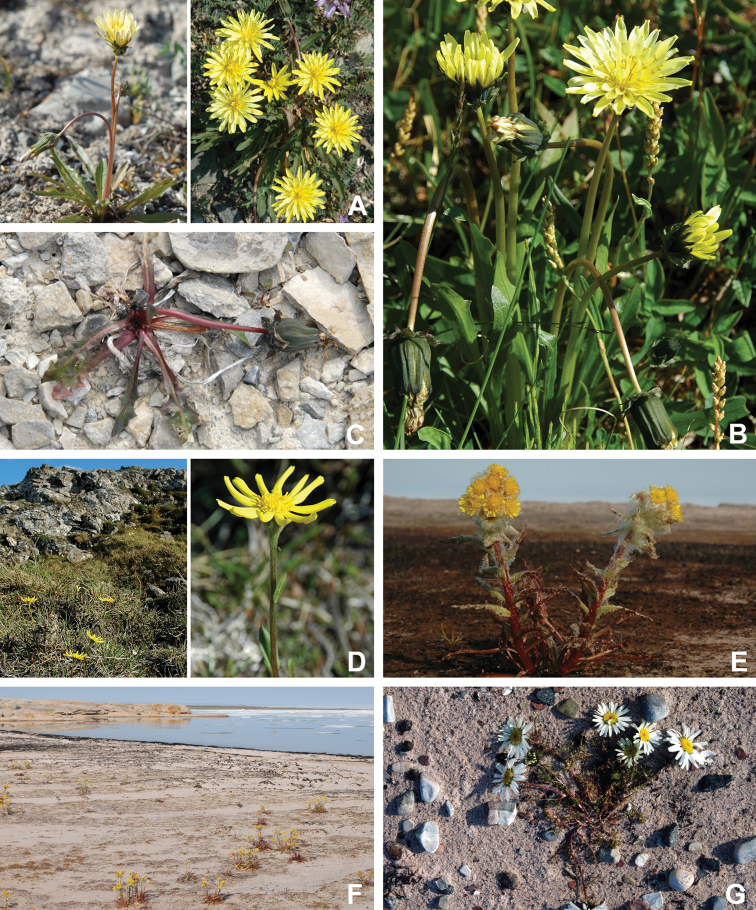
ATaraxacum
hyparcticum habit (left), Gillespie et al. 9746, inflorescences (right), Saarela & Bull 1441BTaraxacum
phymatocarpum habit, Gillespie et al. 9698CTaraxacum
scopulorum habit, Gillespie et al. 9835DTephroseris
frigida habitat (left) and habit (right), Minto Inlet, NT, 25 July 2010 ETephroseris
palustris
subsp.
congesta habit FTephroseris
palustris
subsp.
congesta habitat, Gillespie et al. 8195GTripleurospermum
maritimum
subsp.
phaeocephalum habit, Gillespie et al. 8215. Photos A left, C, F by L.J. Gillespie, and A right, B, D, E, G by R.D. Bull.